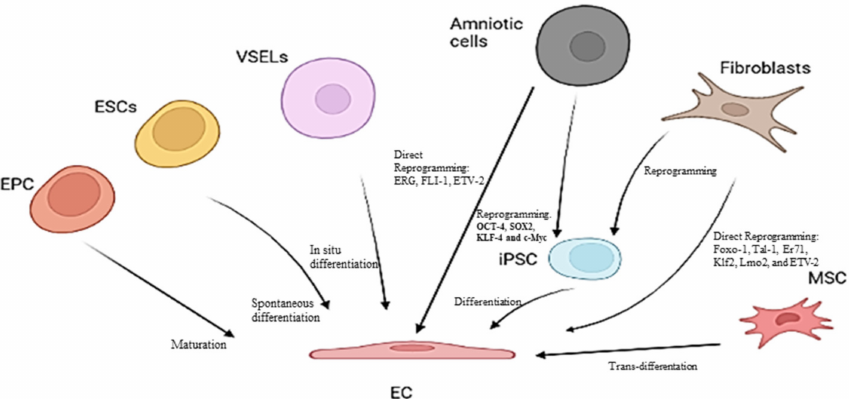
Figure 3. Some strategies for obtaining mature